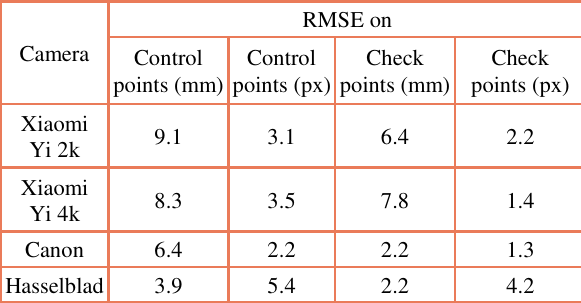
Table 2. The image bundle adjustment accuracy on control and check points according to sensors